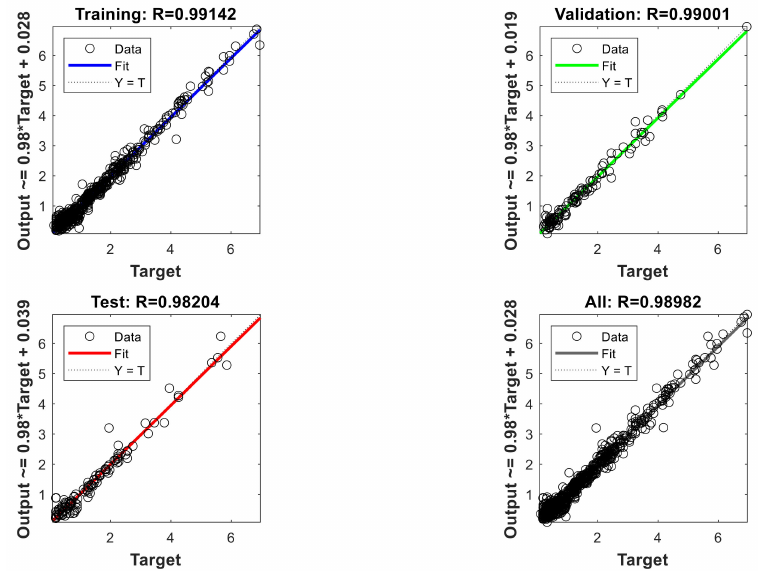
Figure 9. Analysis of the LM-BP-NARX regression